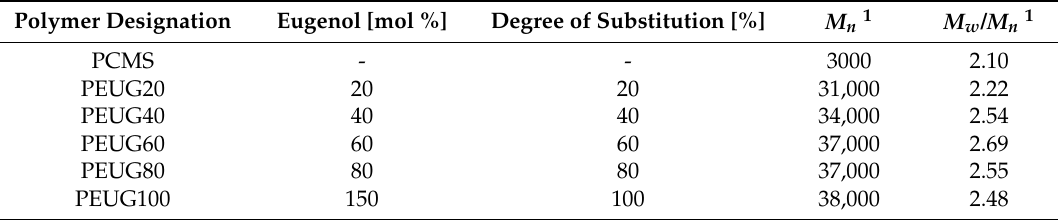
Table 1. Reaction conditions and characterizations for the synthesis of the PCMS and PEUG#.